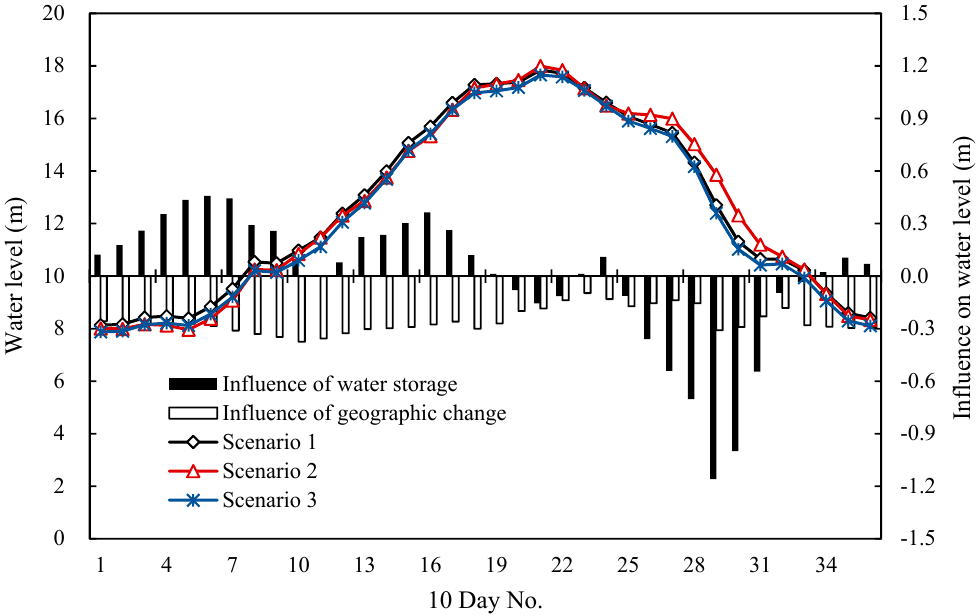
Figure 5. 10 day mean water level at Xingzi Station calculated based on hydrodynamic model simulation. Table 1. 10 day mean water level at Xingzi Station from the model during the time of significant influences.